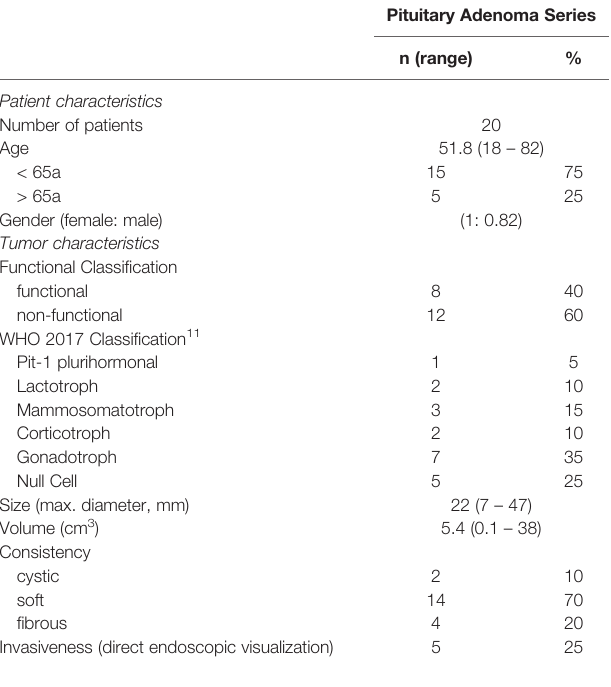
TABLE 1 | Patient and tumor